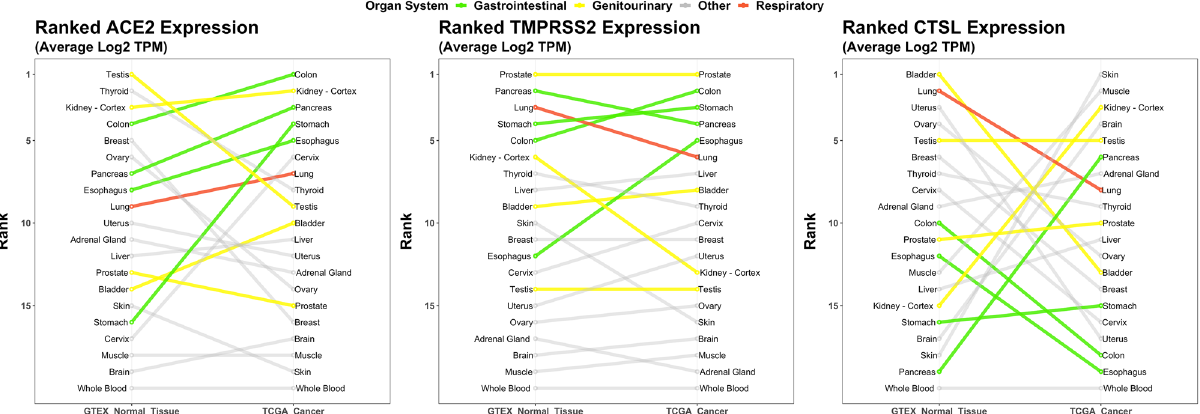
Figure 2. RNA expression of ACE2, TMPRSS2, and CTSL in normal and malignant tissues. RNA expression of ACE2 (left) , TMPRSS2 (middle) , and CTSL (right) in 20 matched normal and malignant tissues from the Genotype-Tissue Expression Portal (GTEx, n = 4,744 Samples) 29 and The Cancer Genome Atlas (TCGA, n = 9,026 Samples) 30 ; respectively. The mean expression in log 2 TPM (transcripts per million) was calculated for each tissue, then ranked based on each gene. Organ systems of interest are highlighted by colour: gastrointestinal tract (green), genitourinary tract (yellow), respiratory tract (red), and other organ systems